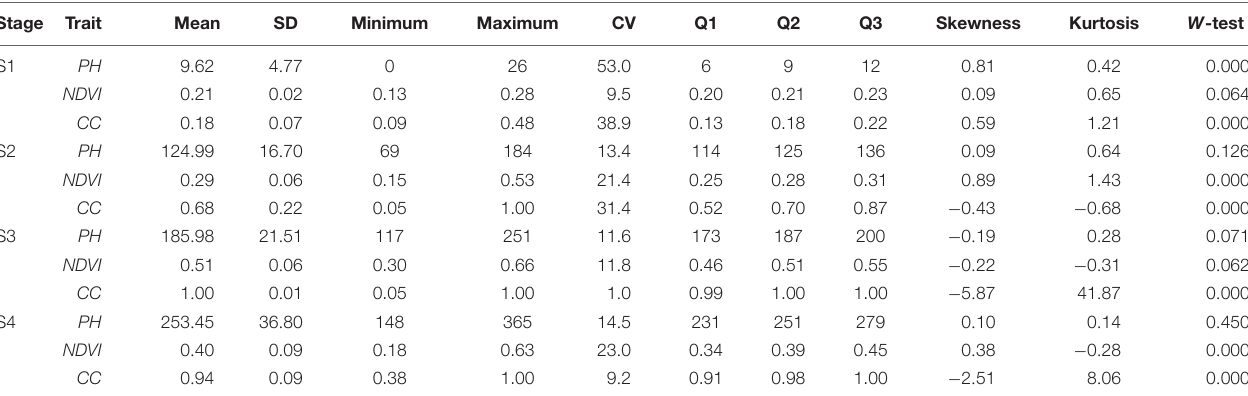
TABLE 2 | Descriptive statistics, normal distribution, and difference in three phenotypic traits during four growth stages. Stage